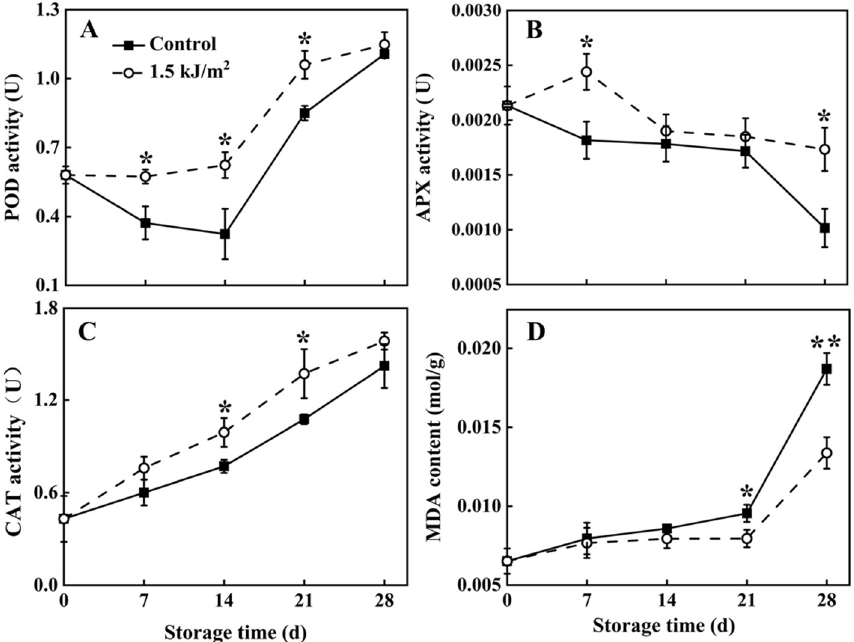
Figure 3. POD activity ( A ), APX activity ( B ), CAT activity ( C ) and MDA content ( D ) of pepino fruit treated with dark (control) and UV-C during storage. POD, APX and CAT activity were measured in pulp tissue; MDA content was measured in peel tissue. Asterisk (*) indicates a significant difference between the control and UV-C treatment groups at p < 0.05. Whereas a double asterisk (**) indicates significance at p < 0.01.